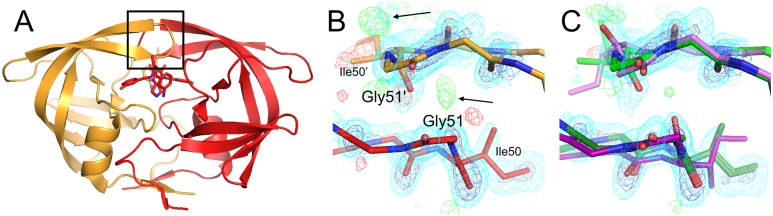
Hidden unmodeled peptide flips in the inhibitor-gating “flaps” of HIV–1 protease.
(A) In the 1.39 Å structure of a mutant of HIV–1 protease bound to a novel inhibitor (PDB ID 3qih), the Ile50-Gly51 tight turn interacts with the dimer-related copy of itself, Ile50’-Gly51’ (boxed region). Chain A in orange, chain B in red. The inhibitor (sticks) binds in two overlapping poses immediately adjacent to these flaps. (B) This dimer interface, viewed as if from above in (A), is asymmetric in the deposited structure: both copies of the peptide point downwards in this view. However, positive difference electron density (arrows) suggest unmodeled conformations. (C) qFit 2.0 models this region with coupled asymmetric peptide flips, such that both copies of the peptide point down (~70%, green) or both point up (~30%, purple) in this view. The multiconformer model has diminished difference electron density peaks, suggesting it is a better local fit to the data. Residual difference peaks may reflect unmodeled partial-occupancy waters that are mutually exclusive with the new protein alternative conformations. 2mFo-DFc contoured at 1.2 σ (cyan) and 3.0 σ (blue); mFo-DFc contoured at +3.0 σ (green) and -3.0 σ (red).